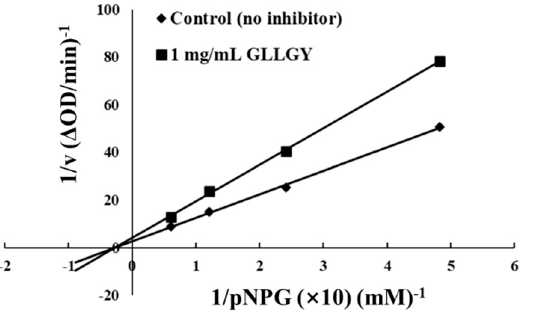
Figure 5. Lineweaver − Burk plots of α -glucosidase catalyzed reactions in the presence of GLLGY.